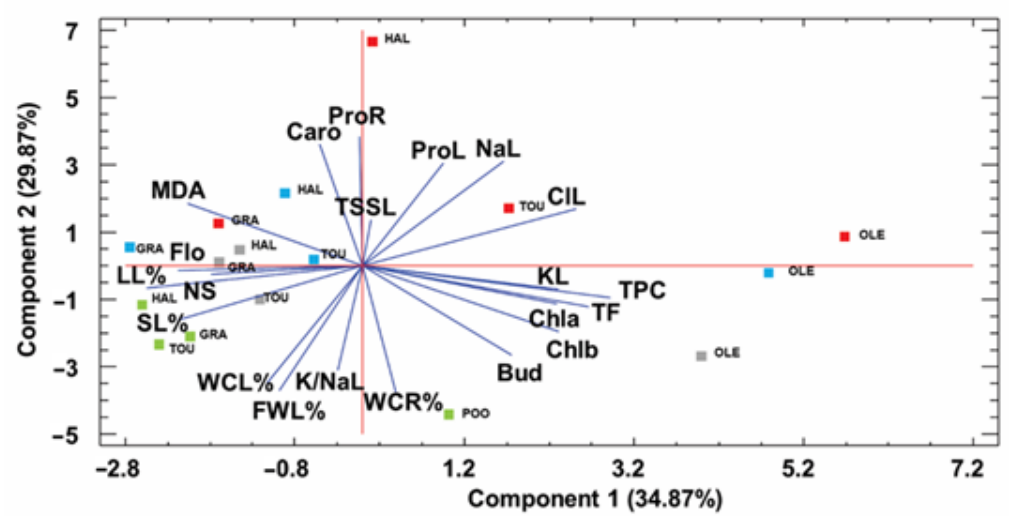
Figure 7. Principal component analysis based on the morphological and biochemical traits measured in plants from control (green), 100 (grey), 200 (blue) and 400 mM (red) NaCl treatments of Portulaca oleracea susbp. oleracea (OLE), P. oleracea cultivar “Toucan Scarlet Shades” (TOU), P. grandiflora (GRA) and P. halimoides (HAL). Abbreviations of the analyzed parameters: SL%, stem length percentage (control being 100%); NS, number of stems; LL%, leaf length percentage (control being 100%); flower bud, number of flower buds; Flo, number of flowers; FWL%, fresh weight percentage of leaves (control being 100%); WCL%, water content percentage in leaves; WCR%, water content percentage in roots; ProL, proline in leaves; ProR, proline in roots; TSS, total soluble sugars in leaves; MDA, malonaldehyde; TPC, total phenolic compounds; TF, total flavonoids; CL, chloride in leaves; NaL, sodium in leaves; KL, potassium in leaves; K / NaL, potassium over sodium ratio in